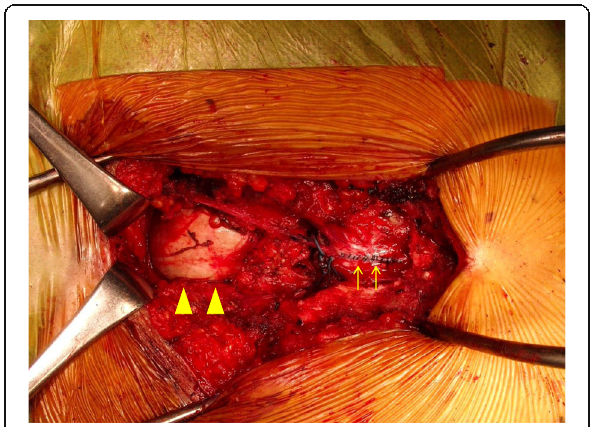
Fig. 3 S3-4 laminectomy was performed, the dura was opened, and